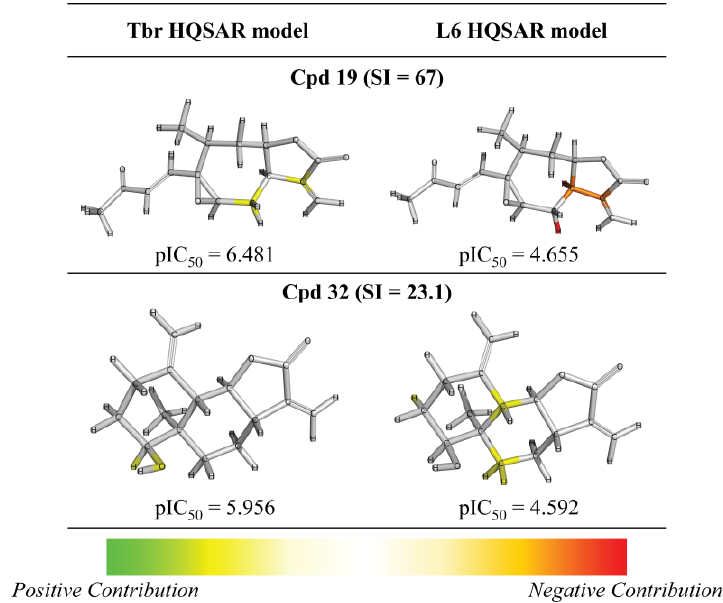
Figure 7. HQSAR maps of most selective